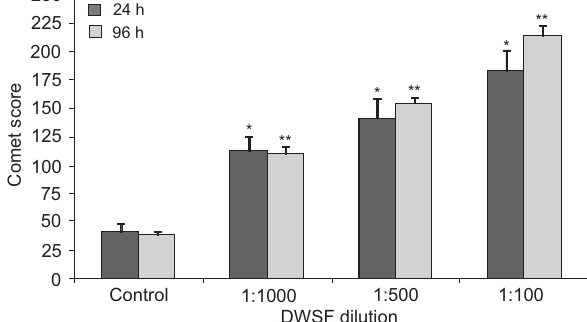
* Indicates a significant difference between results obtained for different dilutions at the same exposure period in comparison to the respective controls as indicated by the Kruskal-Wallis test and the Dunnett's test (p < 0.05). † Indicates significant difference between samples exposed to the same dilution for the two exposure periods (24 and 96 hours) as indicated by the t test (p <